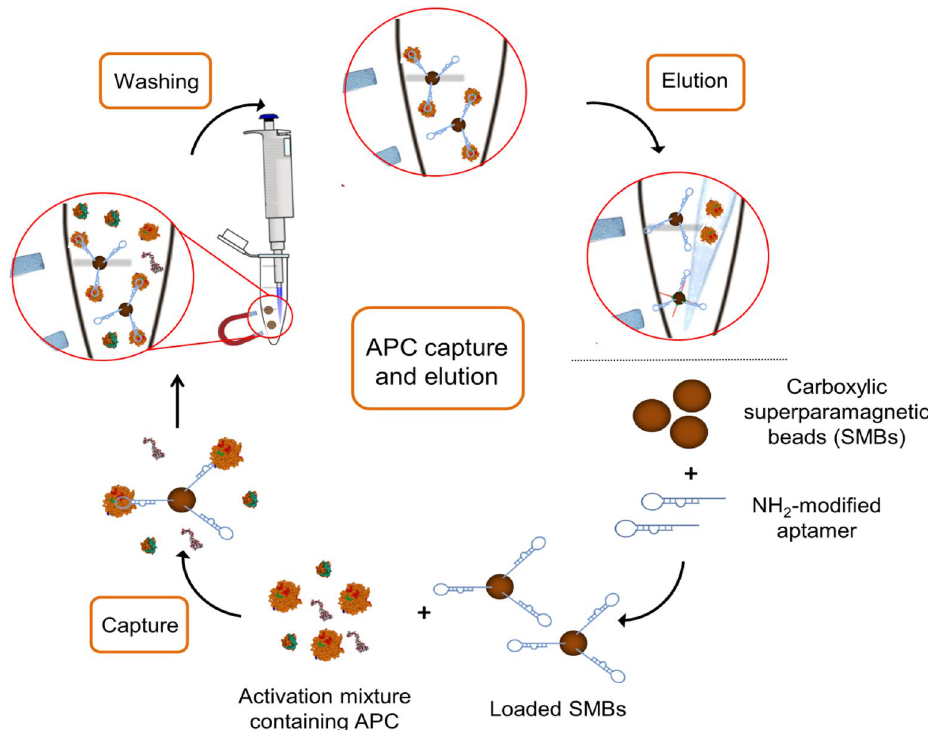
Figure 1. Principle of two-step purification method for capturing and elution of activated protein C (APC) using aptamer-loaded superparamagnetic